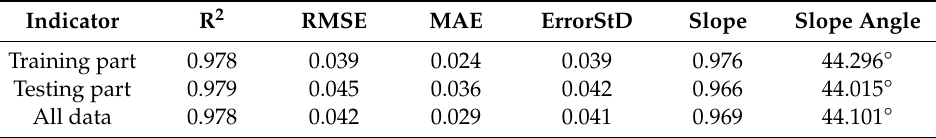
Figure 8. Comparison between actual and predicted data in regression scatter mode for ( a ) training data, ( b ) testing data, and ( c ) all data. Table 5. Performance indicators of the optimal FNN–IWO model.